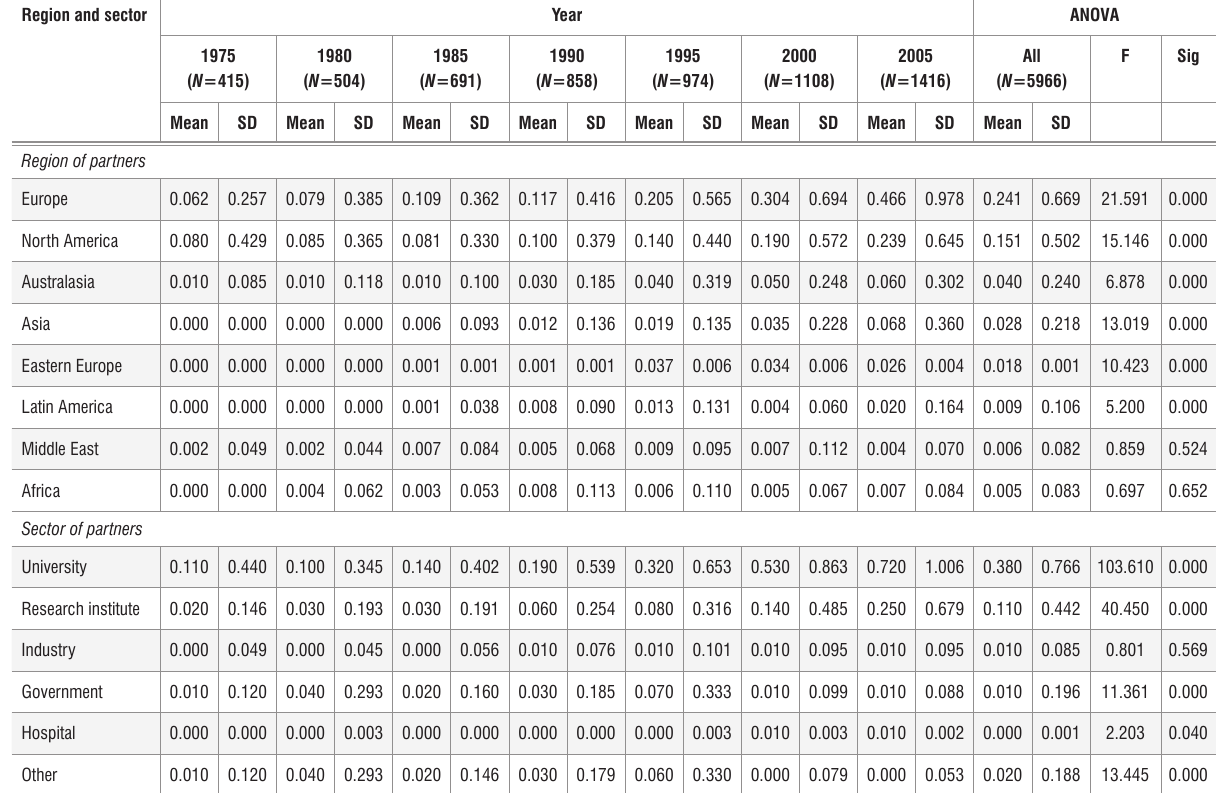
Table 3: Regional and sectoral representation of foreign partners of South African authors in the natural sciences, 1975–2005 Region and